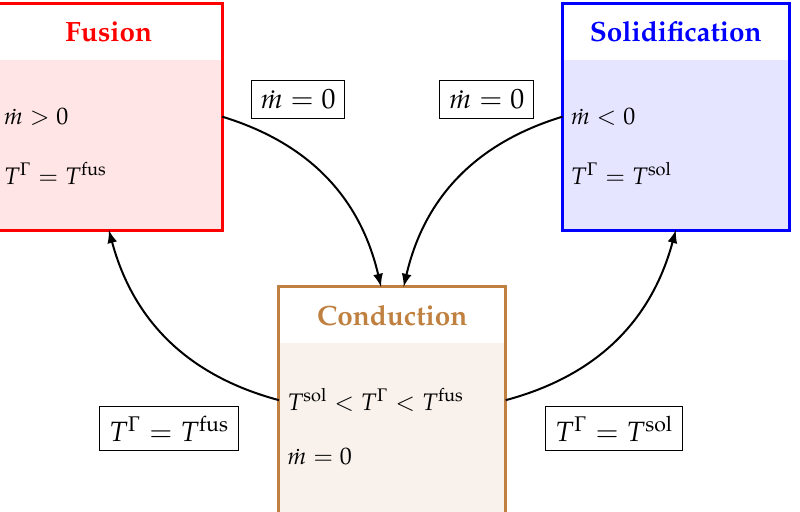
Figure 2. Phase front temperatures T Γ are used to determine the configuration of the front Γ : solidification, fusion or conduction when T fus (cid:54) = T sol . T fus , T sol are constants dependent on the material and geometrical situations. Notice that the change from solidification to fusion must necessarily transition through the conduction